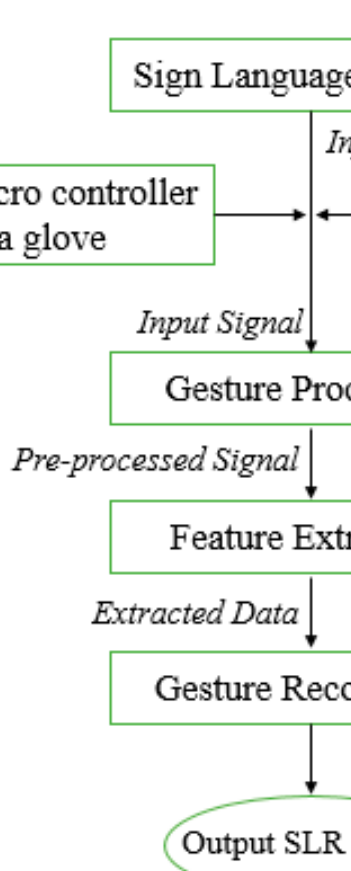
Figure 3. Processing steps for the hybrid SLR system.